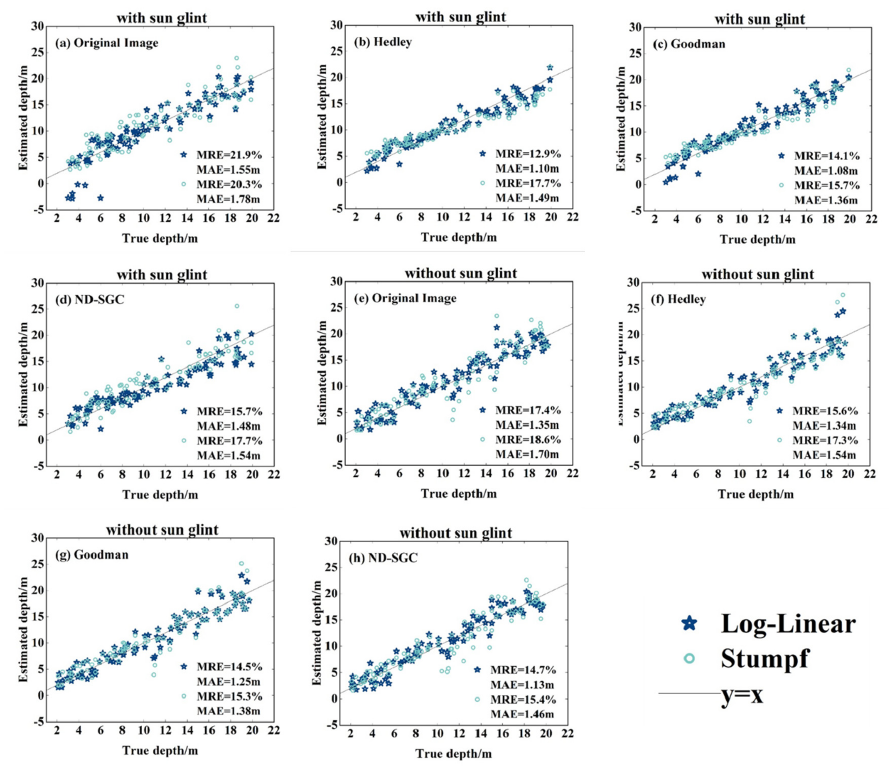
Figure 8. Bathymetric scatter plots of two bathymetric inversion models of the sun glint pixels and sun glint ‐ free pixels of Dongdao Island, and the MRE and MAE of bathymetric inversion. ( a ) Sun glint pixels of the original image; ( b ) Sun glint pixels after Hedley’s method correction; ( c ) Sun glint pixels after Goodman’s method correction; ( d ) Sun glint pixels after ND ‐ SGC method correction. ( e ) Sun glint ‐ free pixels of the original image; ( f ) Sun glint ‐ free pixels after Hedley’s method correction. ( g ) Sun glint ‐ free pixels after Goodman’s method correction; ( h ) Sun glint ‐ free pixels after ND ‐ SGC method correction.